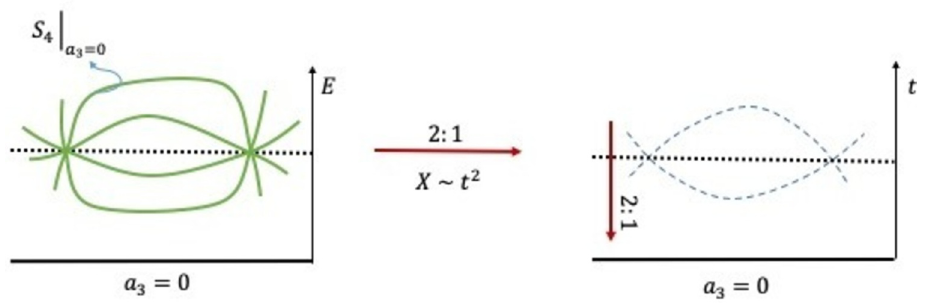
Figure 6 . The green curve in the left picture is the restriction of S 4 over a 3 = 0 . It is s degree 4 cover of the curve a = 0 in the base manifold. Therefore if the two outer sheets correspond to P 3 and P on a fiber such that P (cid:1) P = 0 , then the inner sheets correspond to the points P 2 1 2 √ By locally setting X ∼ t it can be seen as the double cover of a 2